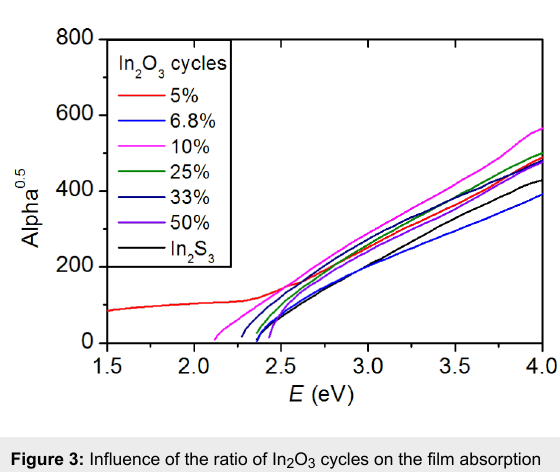
Figure 3: Influence of the ratio of In 2 O 3 cycles on the film absorption spectra when using H 2 O as oxygen precursor.